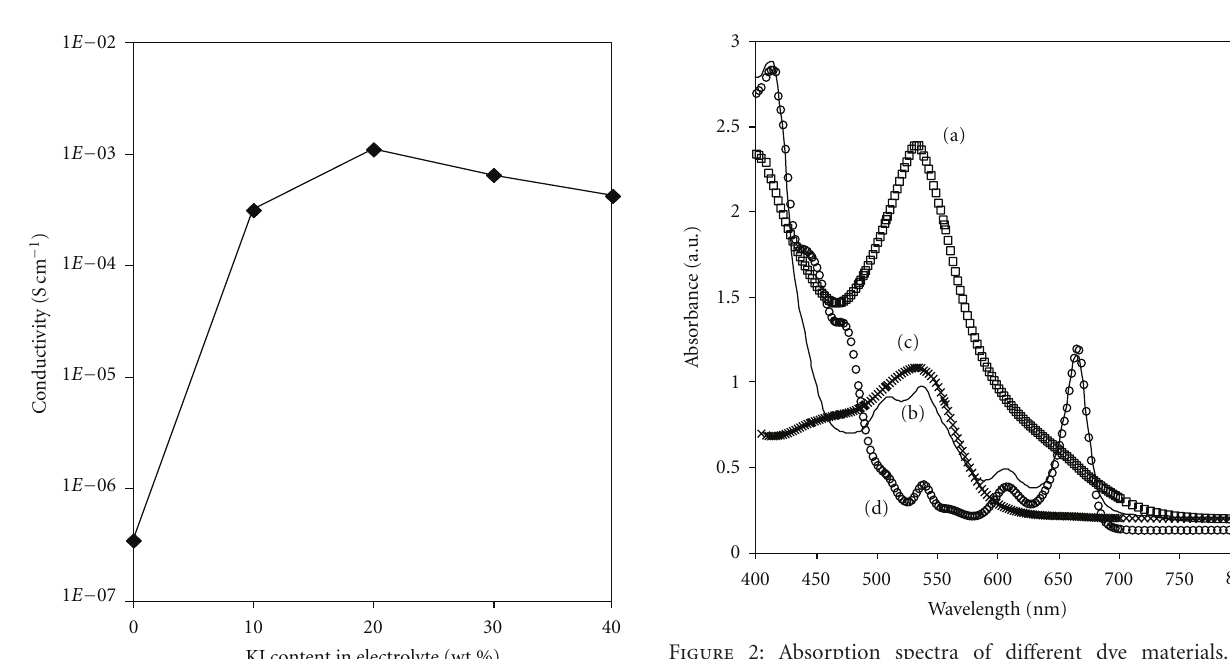
Figure 2: Absorption spectra of di ff erent dye materials. (a) Ruthenizer 535 (N3), (b) anthocyanin/chlorophyll mixture, (c) anthocyanin, (d)